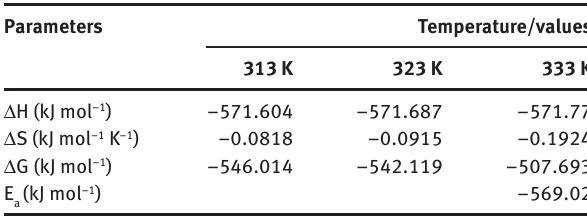
Table 1: Thermodynamic parameters for the esterification reactions of triacetin and hexanol.